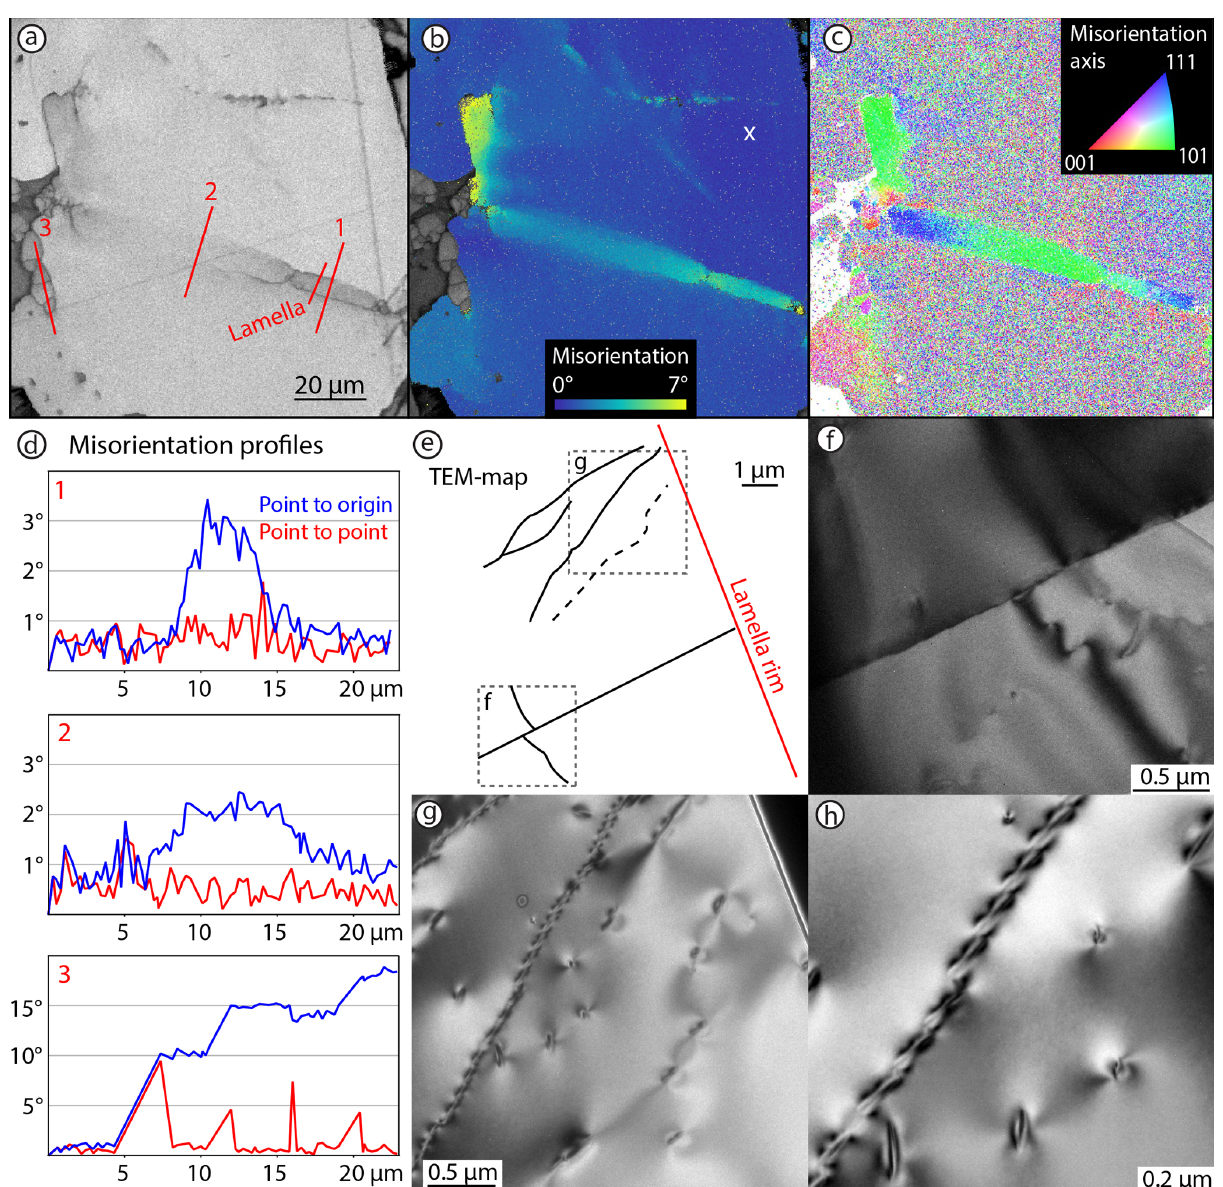
Figure 6. (a) An image quality map of the garnet fragment (compare Fig. 4f) with darker zones that can be interpreted as areas of high dislocation density and the location of the FIB lamella. (b) A misorientation plot with respect to the reference point (marked with the white x ) shows a discrete zone of misorientation, which has discrete boundaries in the right part of the image but is more distributed towards the left. (c) A misorientation axis plot with respect to the average orientation of the grain shows a consistent rotation around the (101) and (111) axes. For pole figure plots, see Fig. A2. (d) Misorientation profiles indicated in (a) for (1) the narrow zone, (2) the more distributed zone and (3) subgrains. (e) An overview sketch of the FIB lamella used for TEM analysis for correlation with the EBSD data. (f) A sharp contrast boundary in the lower part of the lamella. (g) Two dislocation walls with a few free dislocations, which are partly linking up parallel to the dislocation walls. (h) Detail of the centre of (g)